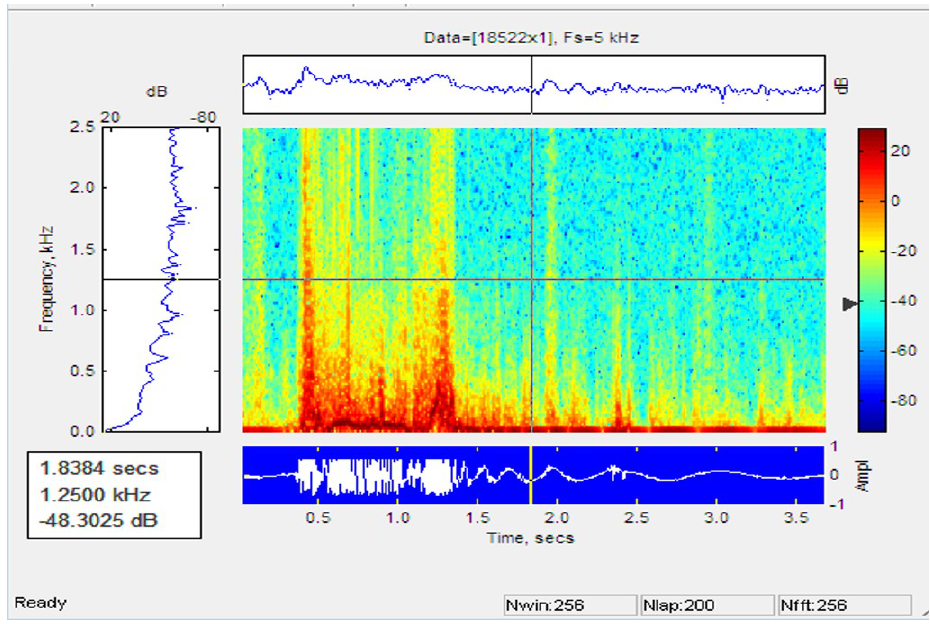
Figure 19. Spectogram of signal for running of single person. Figures 20 and 21 represent the signal trace and the one-person jump spectrogram. It can be seen from the chart that there is a peak when the person jumps close to the sensor cable.